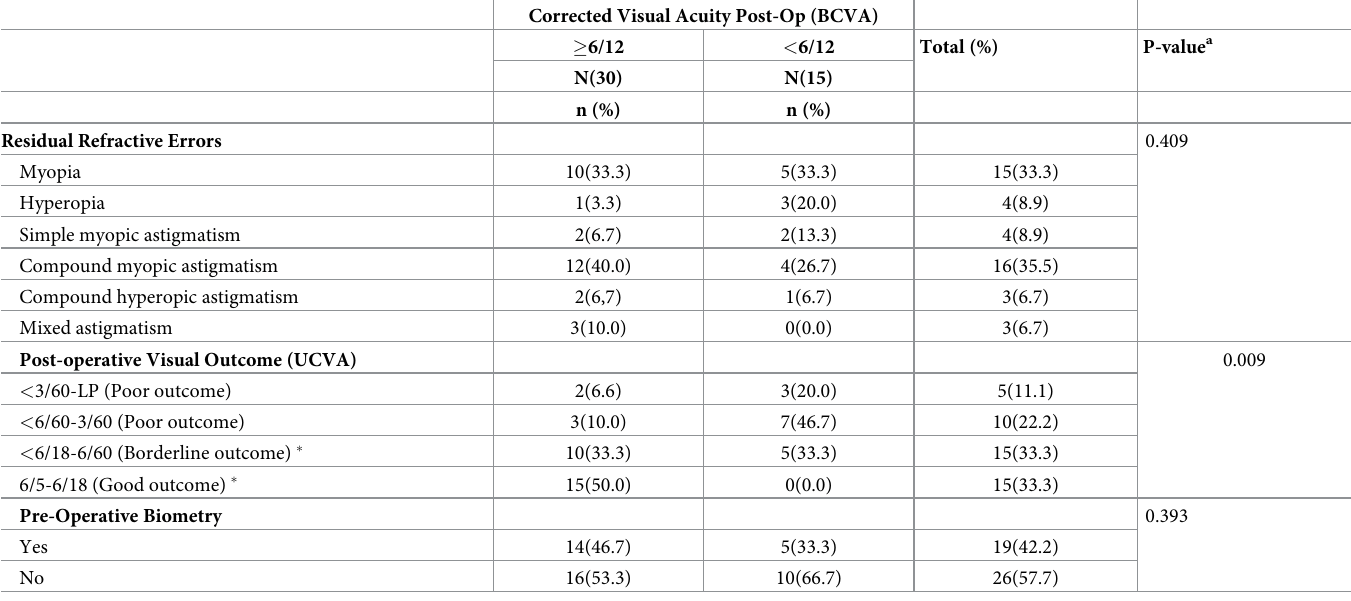
Table 4. The refractive error correction outcomes at post-operative